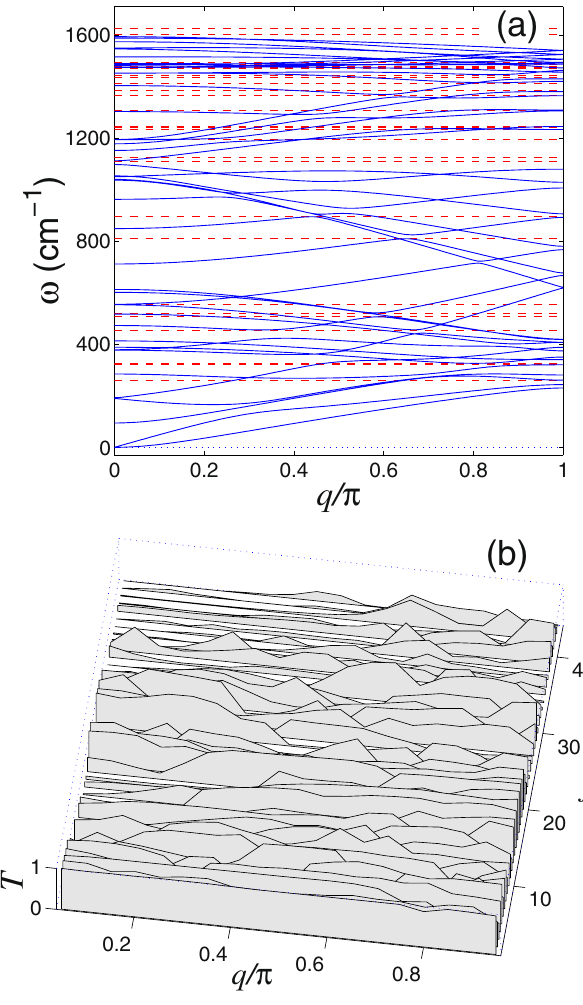
Figure 7. ( a ) Dispersion curves (2 N e in total) of the in-plane oscillations of an armchair nanoribbon. Number of atoms in the elementary cell is N e = 22. ( b ) Transmission coefficient T vs. wavenumber q for each dispersion curve ( j stands for the sequential number of a dispersion curve) for phonons scattered by the double vacancy V 2 (585). The average transmission coefficient of such phonons is = . T 0 445 . Horizontal dashed straight lines mark the eigenfrequencies of the in-plane localized vibrations of the